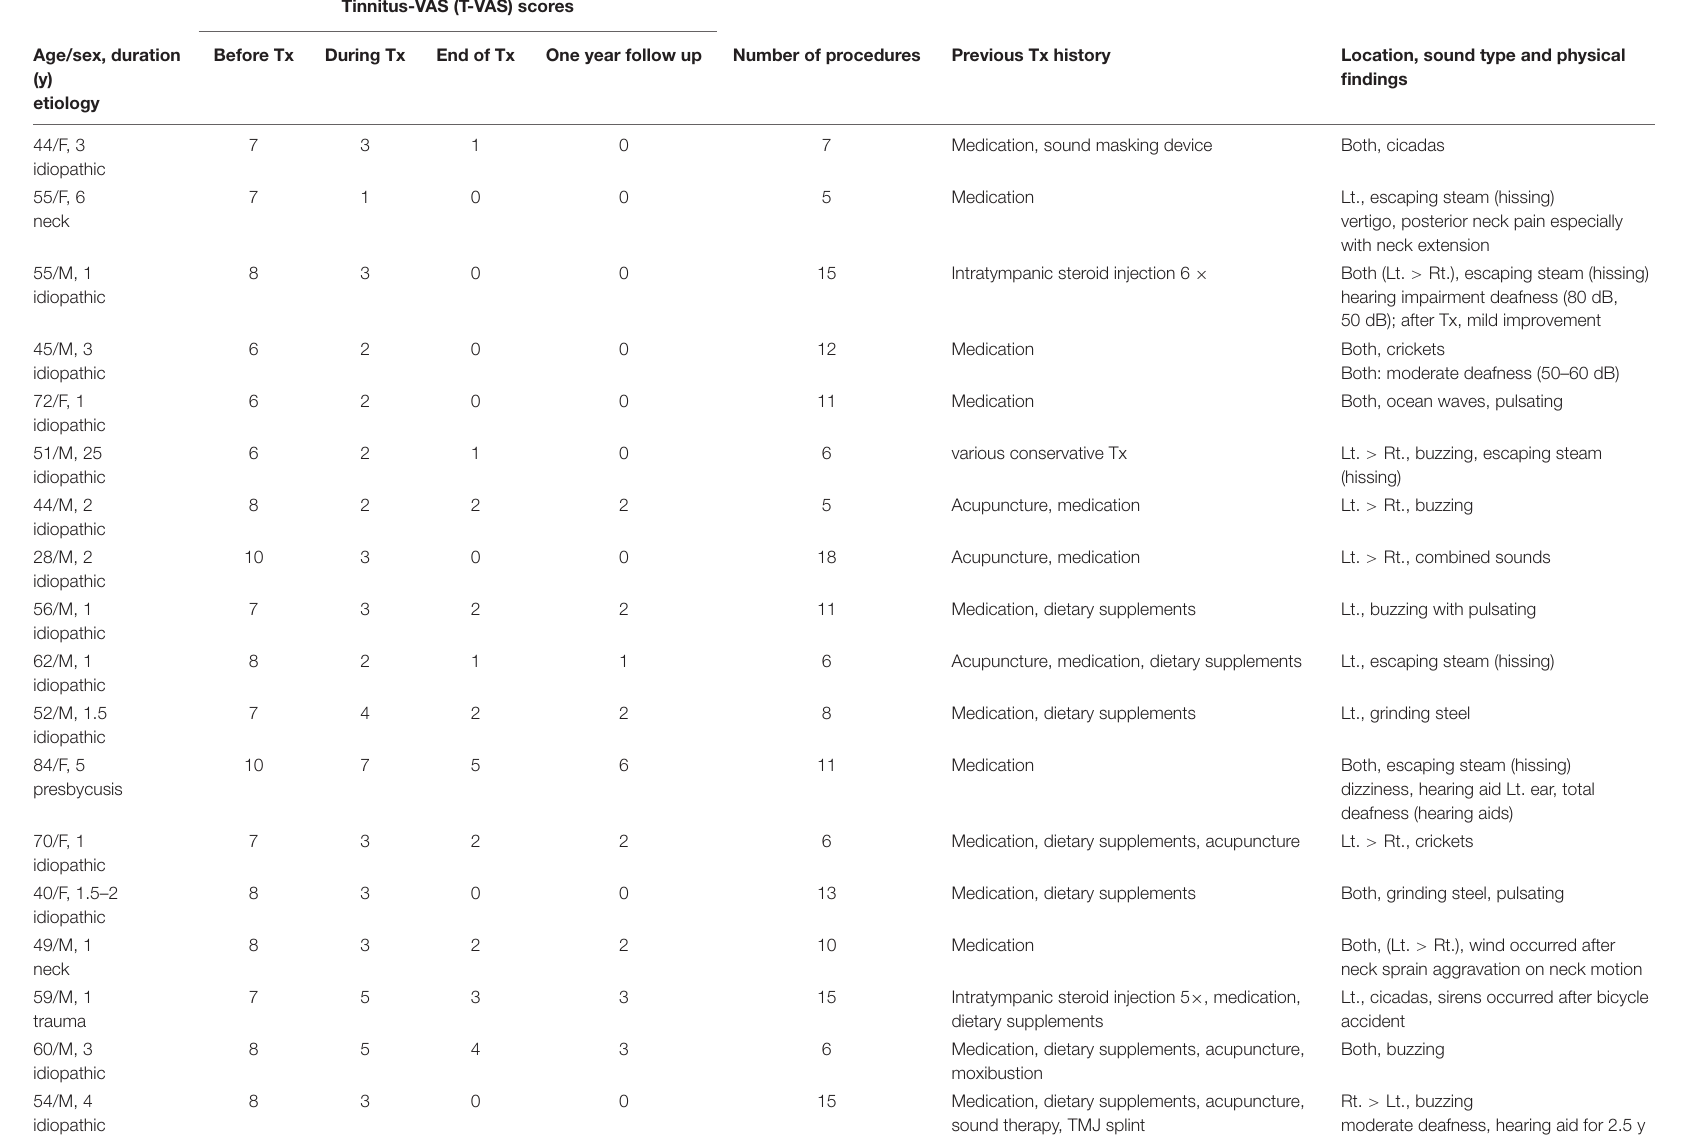
TABLE 2 | Demographic data, visual analog scale (VAS) scores and clinical data in chronic